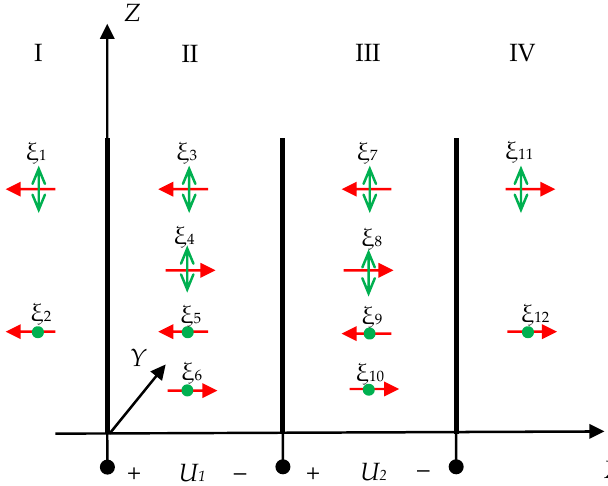
Figure 5. The multilayer system for direct CPAW radiation.